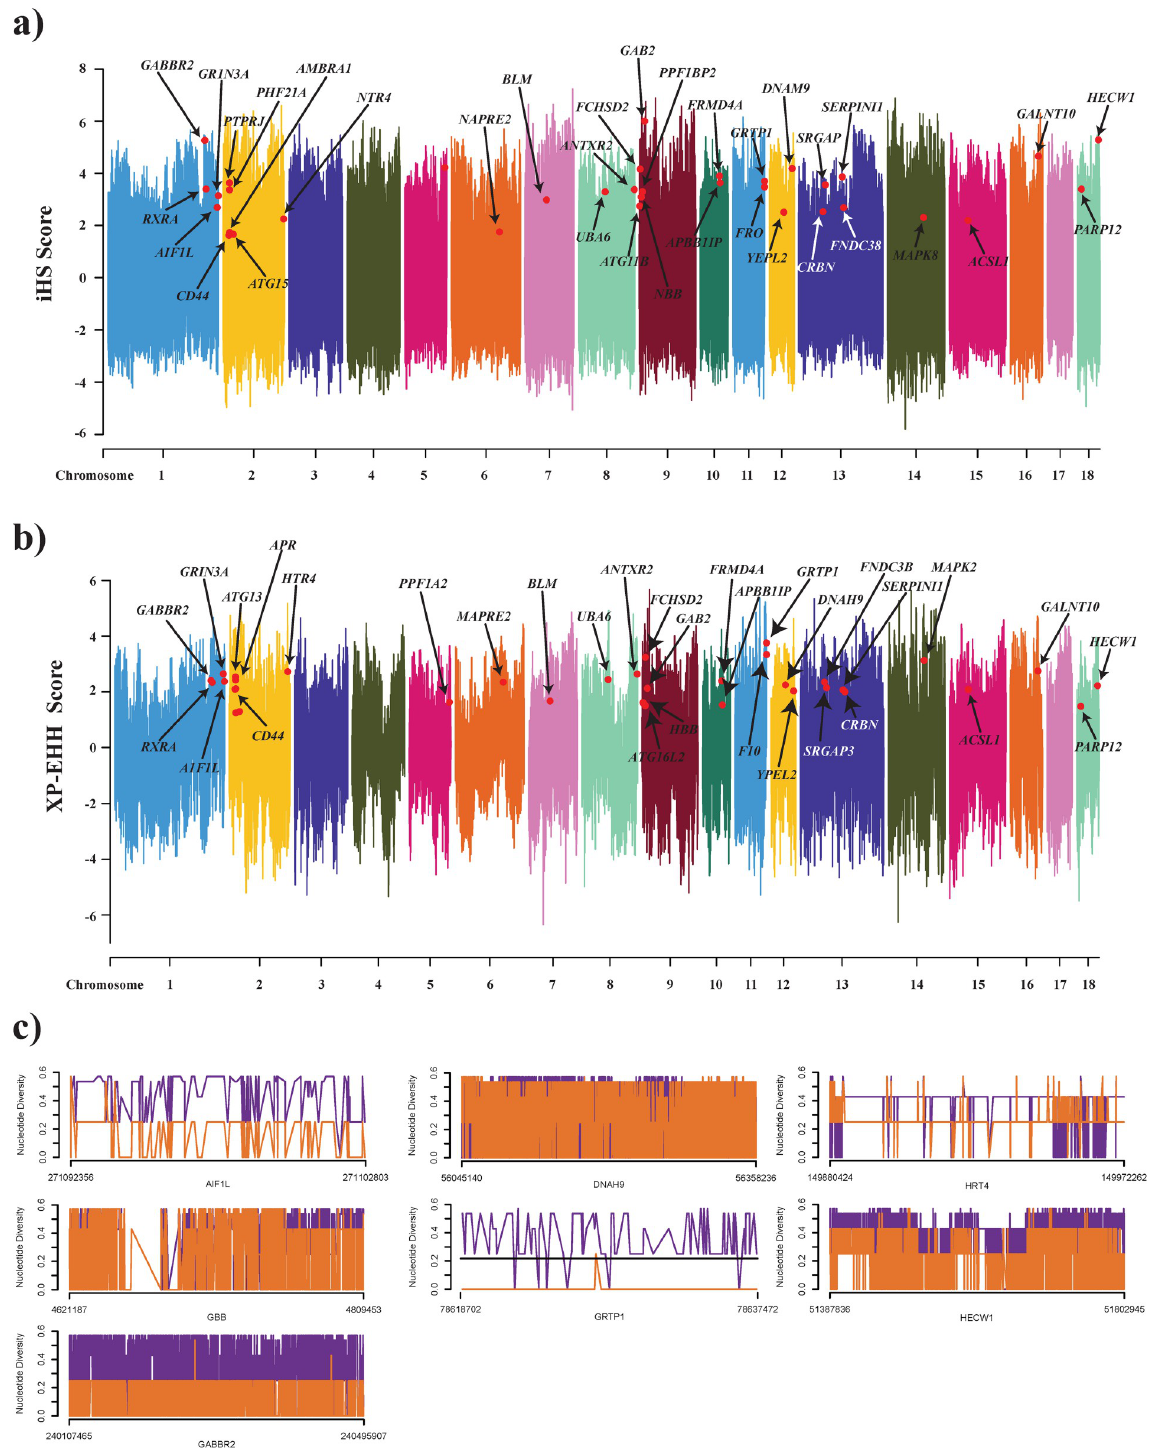
Fig 3. (a) Manhattan plot was generated to map the coordinates of identified genes on respective location of the chromosomes in iHS and XP-EHH. (b) These identified genes were further analyzed for nucleotide distribution comparison analysis in LvsET minipig and understanding the stability and gene